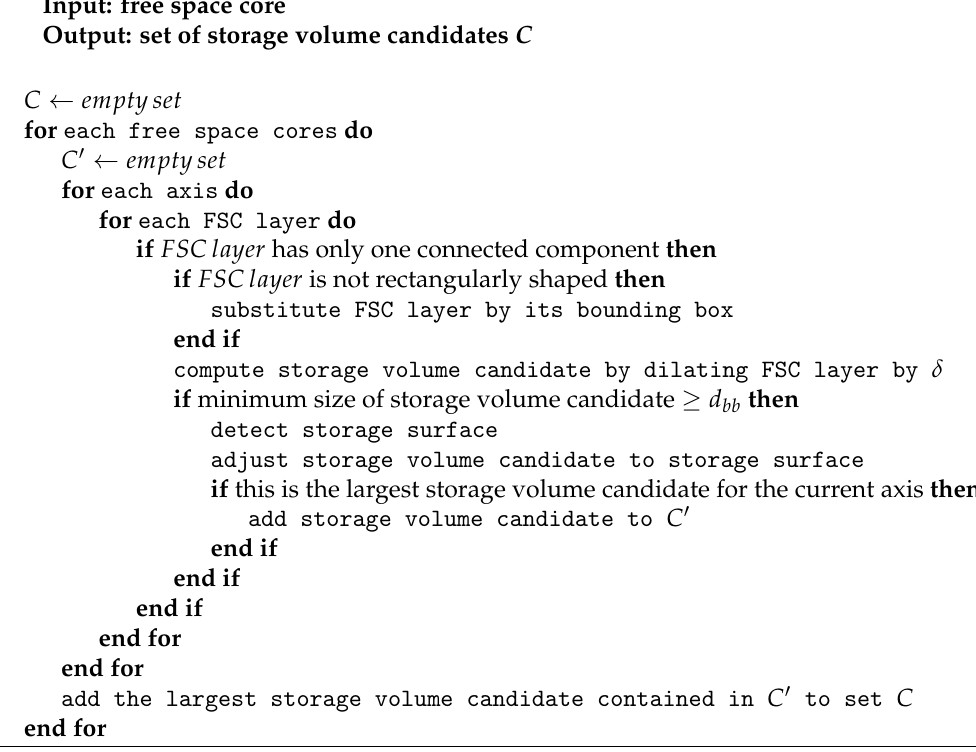
Algorithm 2 An algorithm for detection of usable empty storage volumes in the occupancy